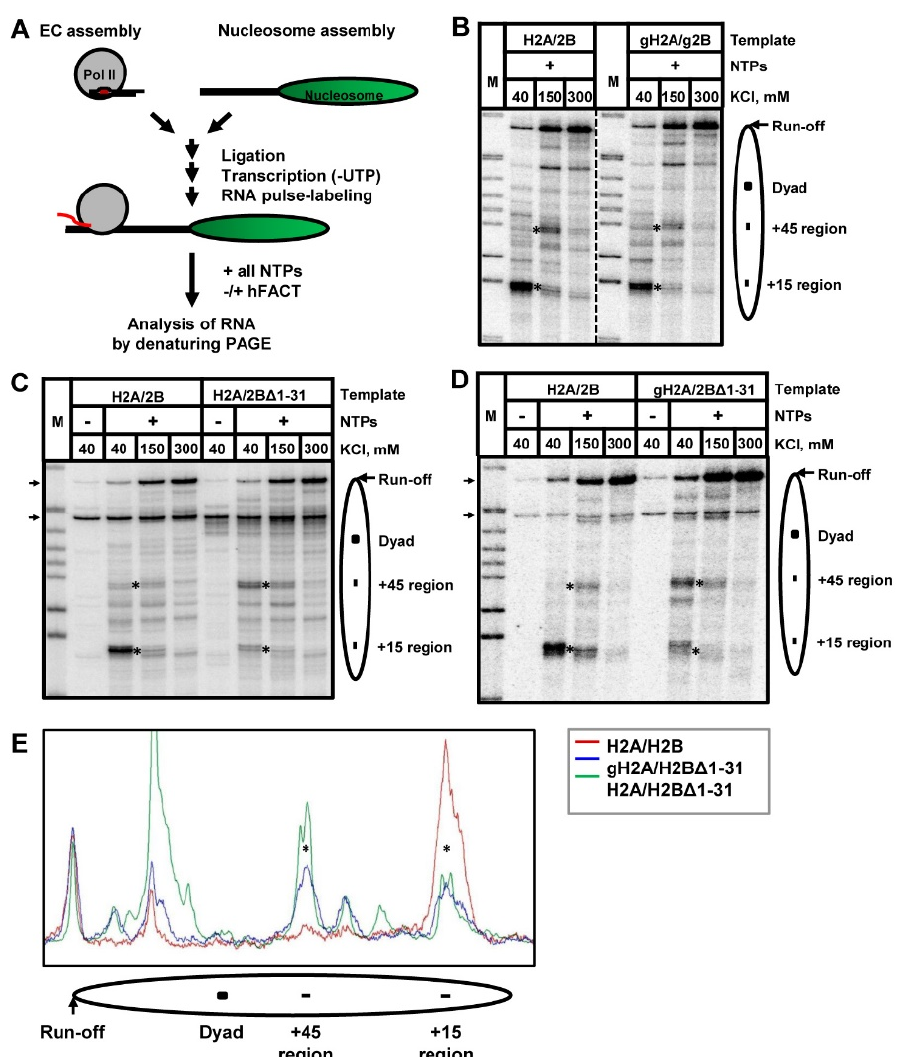
pausing is less pronounced (Figure 4E). Thus, the data suggest that the presence of the 27– 31 region of histone H2B dictates the efficiency of Pol II transcription through the +(11– 15) region of the nucleosome.